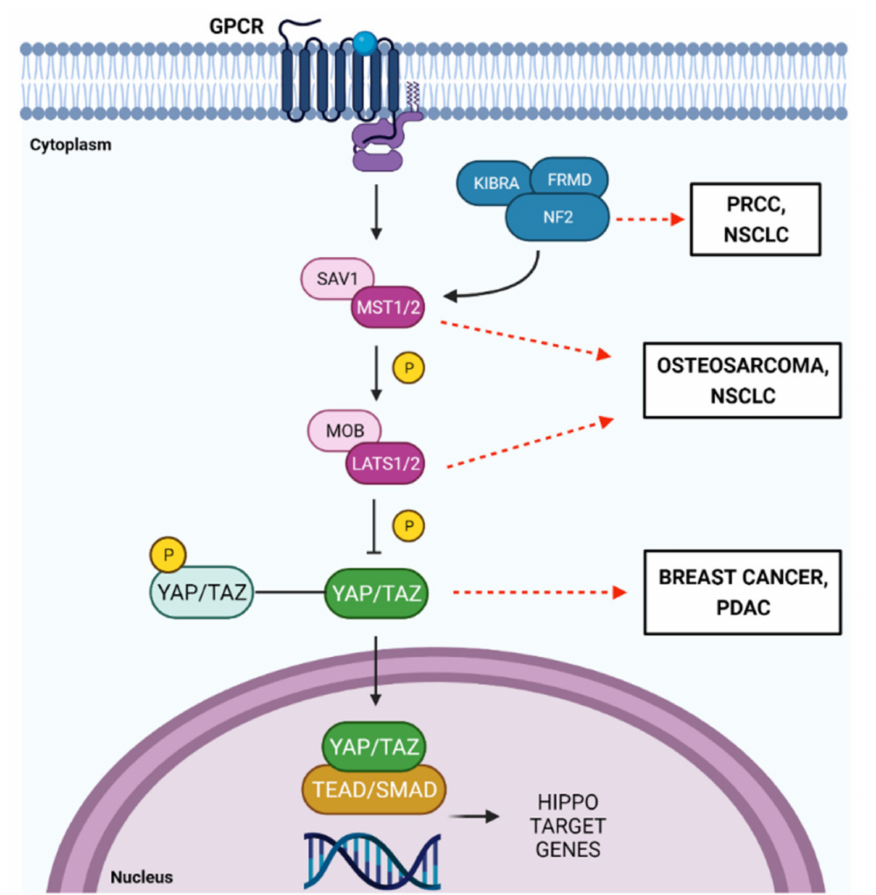
Figure 3. Hippo Pathway deregulated in human cancer, from the top: alteration of the tumor suppressor gene NF2 in the Papillary renal cell carcinomas (PRCC) [144]. Generally, it has been shown that the transcription factor YAP is a determining element in the progression of renal cancer, particularly in PRCC because it promotes tumor angiogenesis and its silencing increases the apoptotic rate and causes arrest of the cell cycle [146,147]. In the non-small cell lung cancer (NSCLC) the loss of function of some key Hippo Pathway genes, as well LATS1/2 and NF2, causes resistance to BET protein inhibitors (BETi) [151–153]. In osteosarcoma cells, methotrexate and doxorubicin (Dox) drugs damage the kinases MST1/2 and LATS1/2 activity by decreasing the phosphorylation of YAP allowing its translocation into the nucleus [148,149]. Drugs resistance is characteristic of this pathology and is one of the main causes of poor prognosis [150]. The overexpression of the YAP1 gene is present in Breast cancer (BC). YAP can induce EMT, increase the number of tumor stem cells and inhibit cell apoptosis in vitro [147–149]. In the Pancreatic ductal adenocarcinoma (PDAC) YAP is overexpressed in tumor samples from pancreatic cancer patients [157–161]. Furthermore, YAP acts as a transcriptional switch down stream of KRAS, supporting the expression of genes that promote neoplastic proliferation and stromal response [162]. Created with